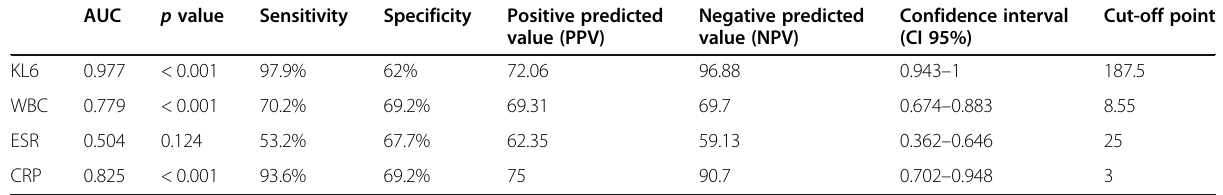
Table 6 ROC curve analysis of KL6, WBCs, ESR, and CRP between stable and exacerbation AUC p value Sensitivity Specificity Positive predicted